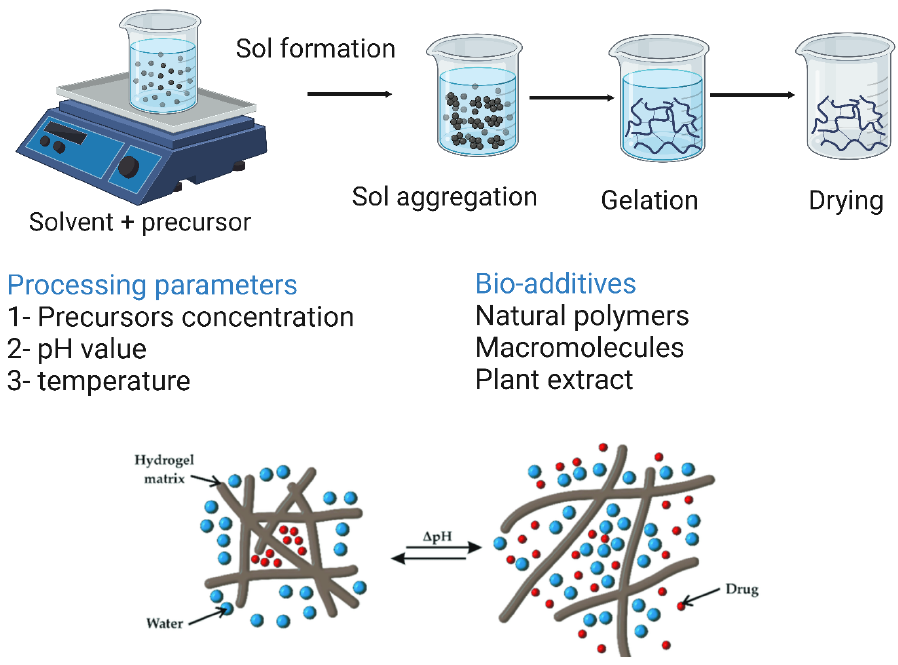
Figure 13. The sol–gel formation technique and its processing parameters and additives. The image was created using Biorender. was created using